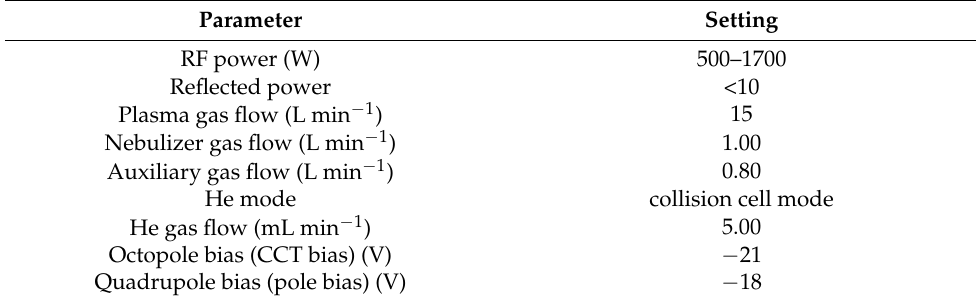
Table 2. Operating conditions and acquisition parameters for ICP-MS.